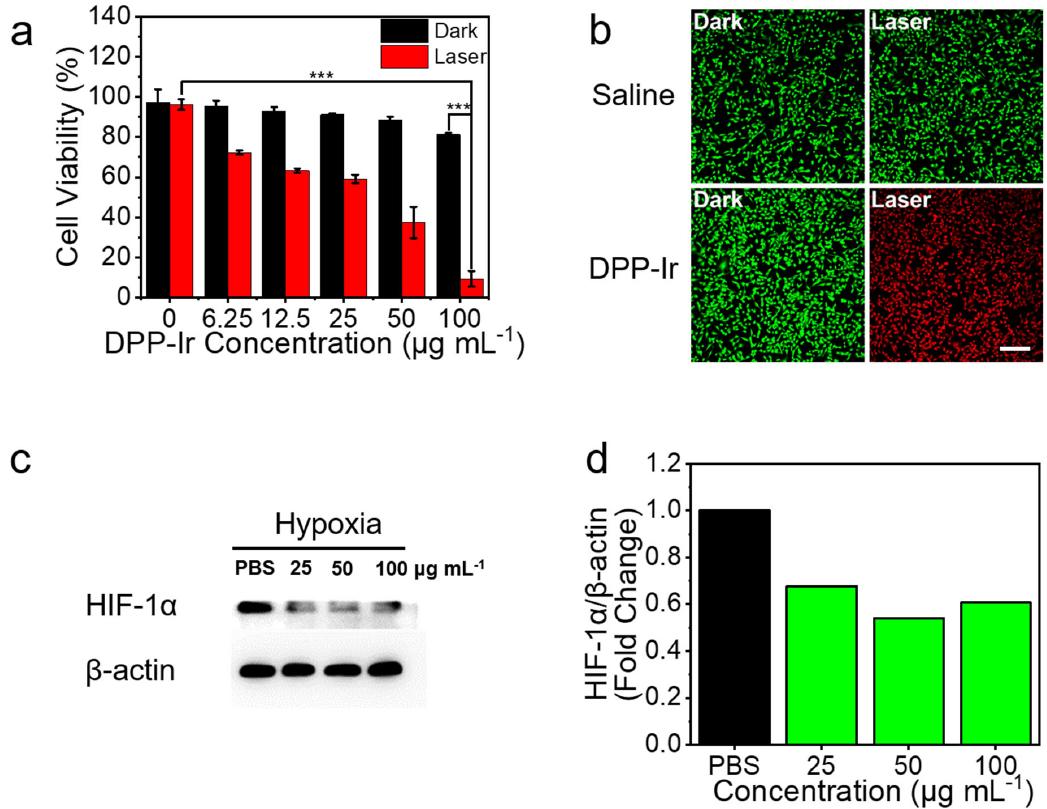
Figure 4. ( a ) Viability of MDA-MB-231 cells treated with different concentrations of DPP-Ir nanoparticles with/without laser radiation (808 nm 1.0 W cm − 2 10 min). ( b ) Fluorescence images of calcein-AM (green, live cells) and PI (red, dead cells)-co-stained MDA-MB-231 cells. ( c ) Western blot analysis of HIF-1 α protein level in MDA-MB-231 cells’ incubation with DPP-Ir nanoparticles. ( d ) Gray value analysis of Western blot strips. *** p <